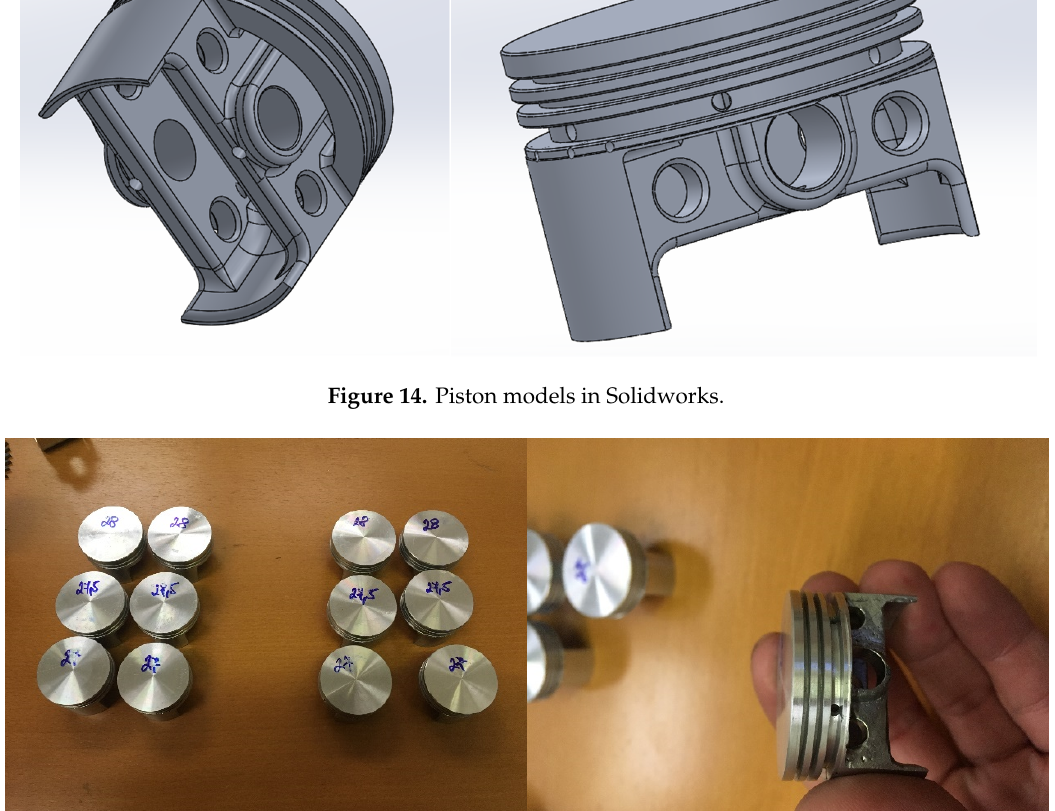
Figure 16. Mounted throttle system with electronic opening control and injector.